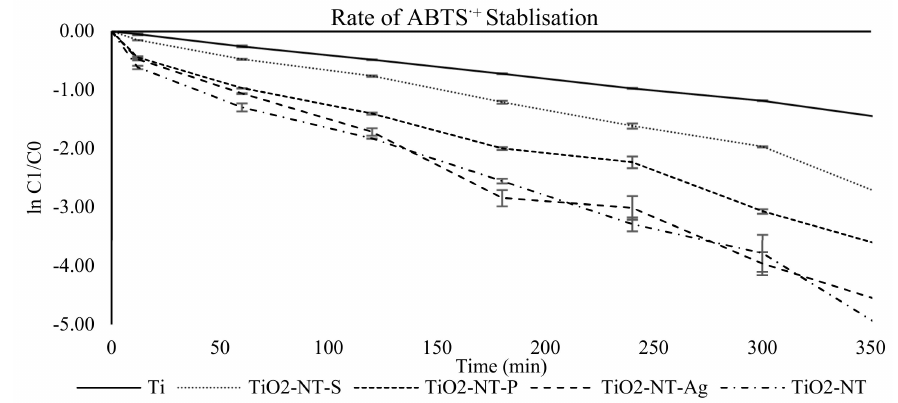
Figure 6. Rate of reaction for the stabilisation of ABTS radical cations using TiO 2 nanotube arrays with di ff erent morphologies exposed to 10 mWcm − 2 UV.